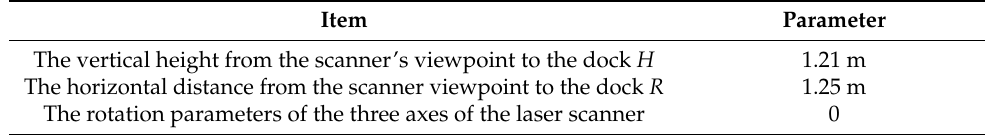
Table 3. Experimental details.